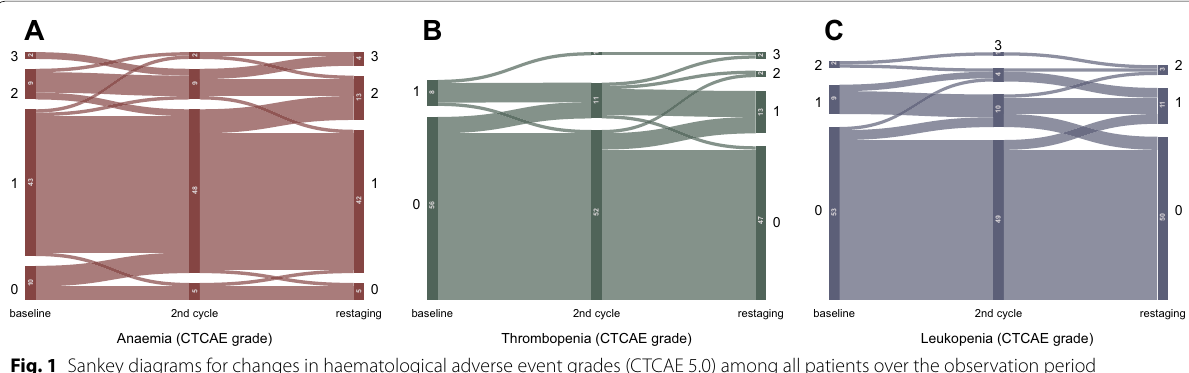
Common Toxicity Criteria for Adverse Events version 5.0 [10] =